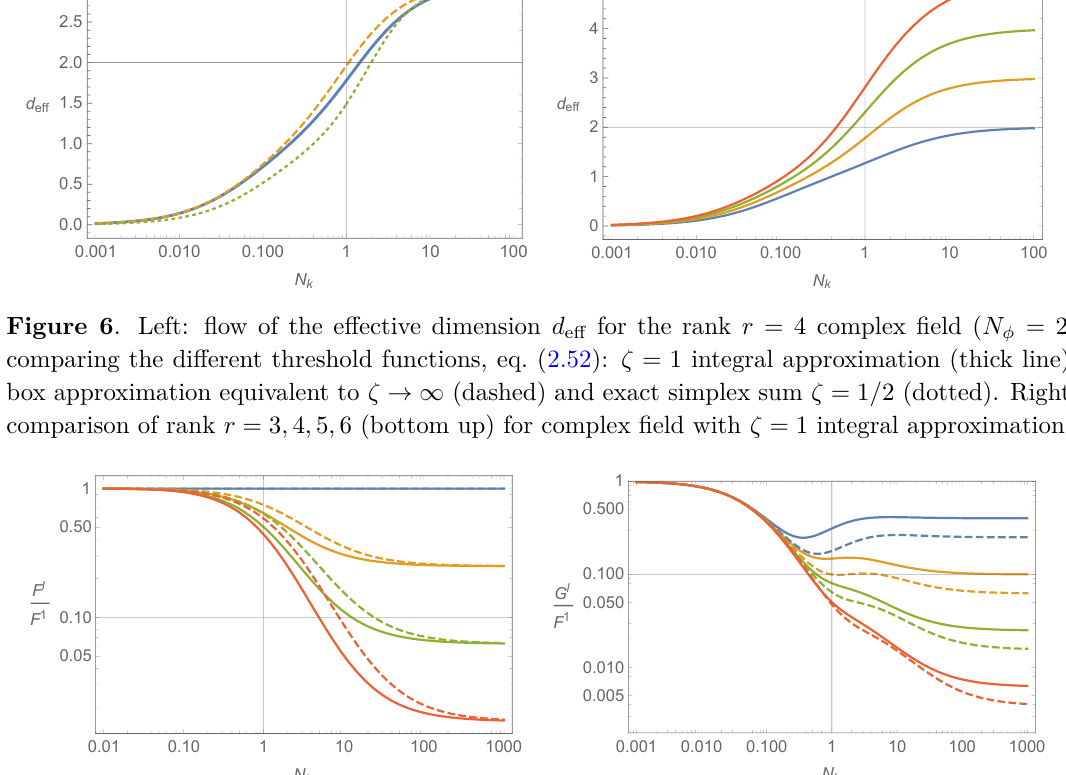
Figure 7 . Flow of the ratio F l with N φ = 2 in the integral approximation for ζ = 1 and ζ = 1 / 2 (dashed) for